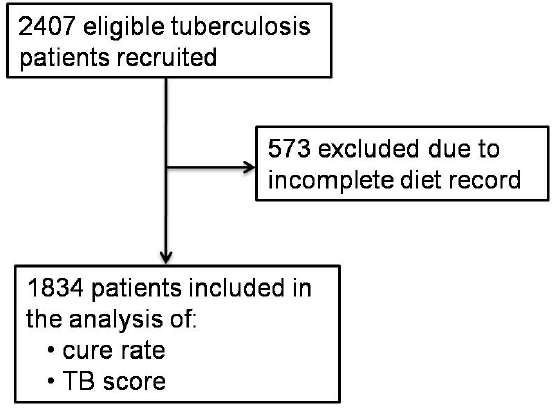
Figure 1. Trial flow.